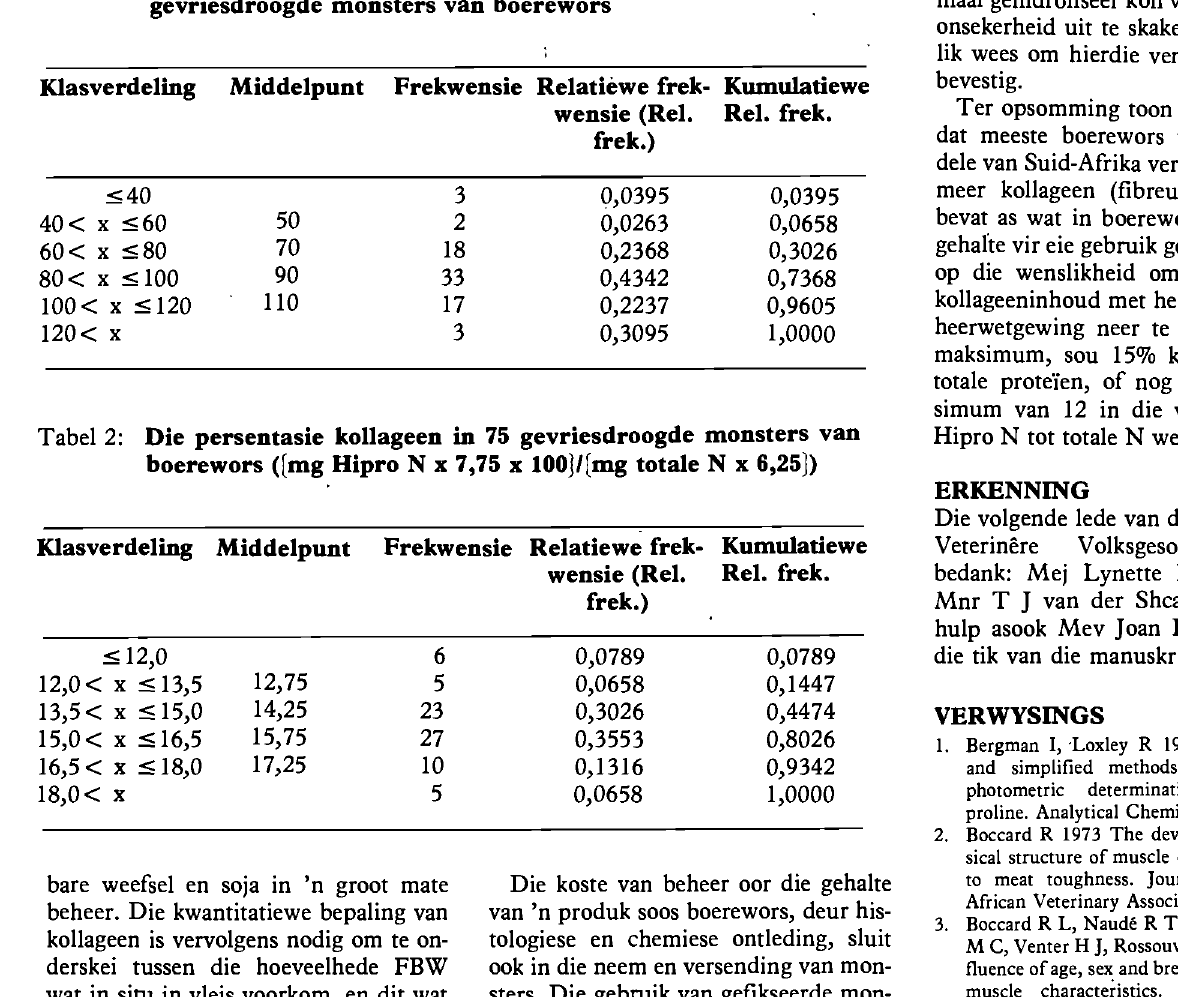
Tabel 1: Frekwensie-verdeling van mg kollageen (Hipro N x 7,75) in 75 gevriesdroogde monsters van boerewors